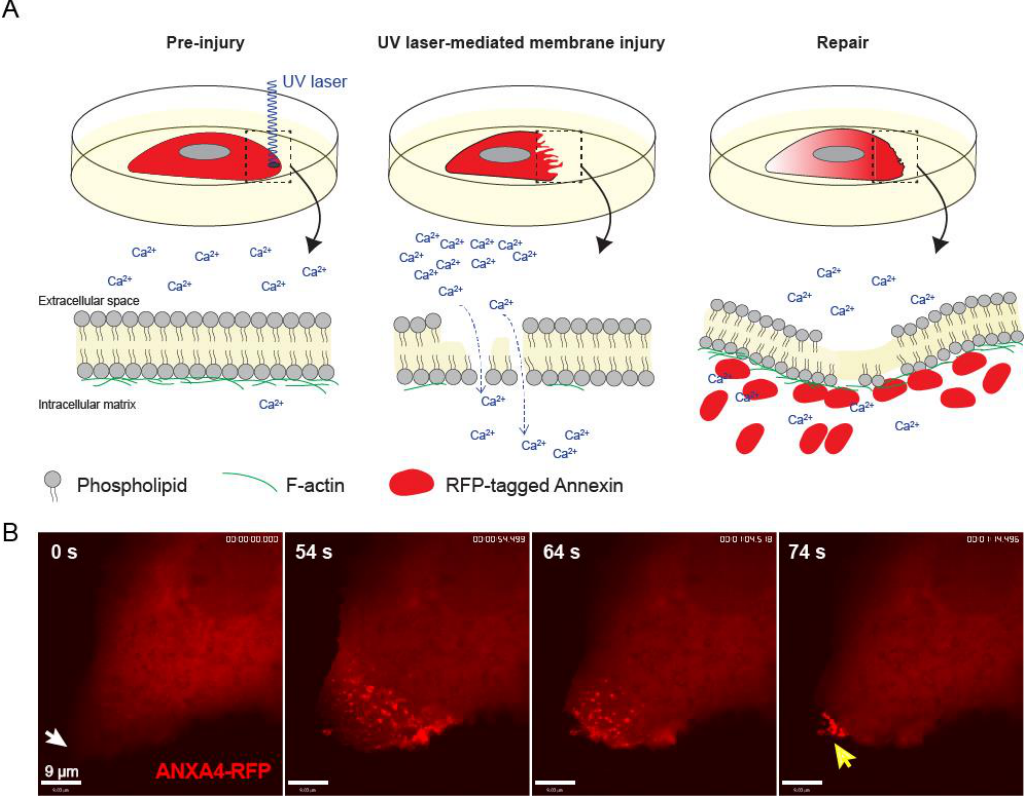
Figure 4. Plasma membrane injury inflicted by UV-laser ablation injury. ( A ) Schematic of ablation laser injury to monitor annexin behavior during plasma membrane repair. Ca 2+ influx through the wounded membranes activates and enables annexin to bind and seal the hole by bending membrane and glue membrane edges together. ( B ) Sequential images from time-lapse movie of a MCF-7 breast carcinoma cell showing translocation behavior of ANXA4-RFP to the site of damage (white arrow) upon laser injury.